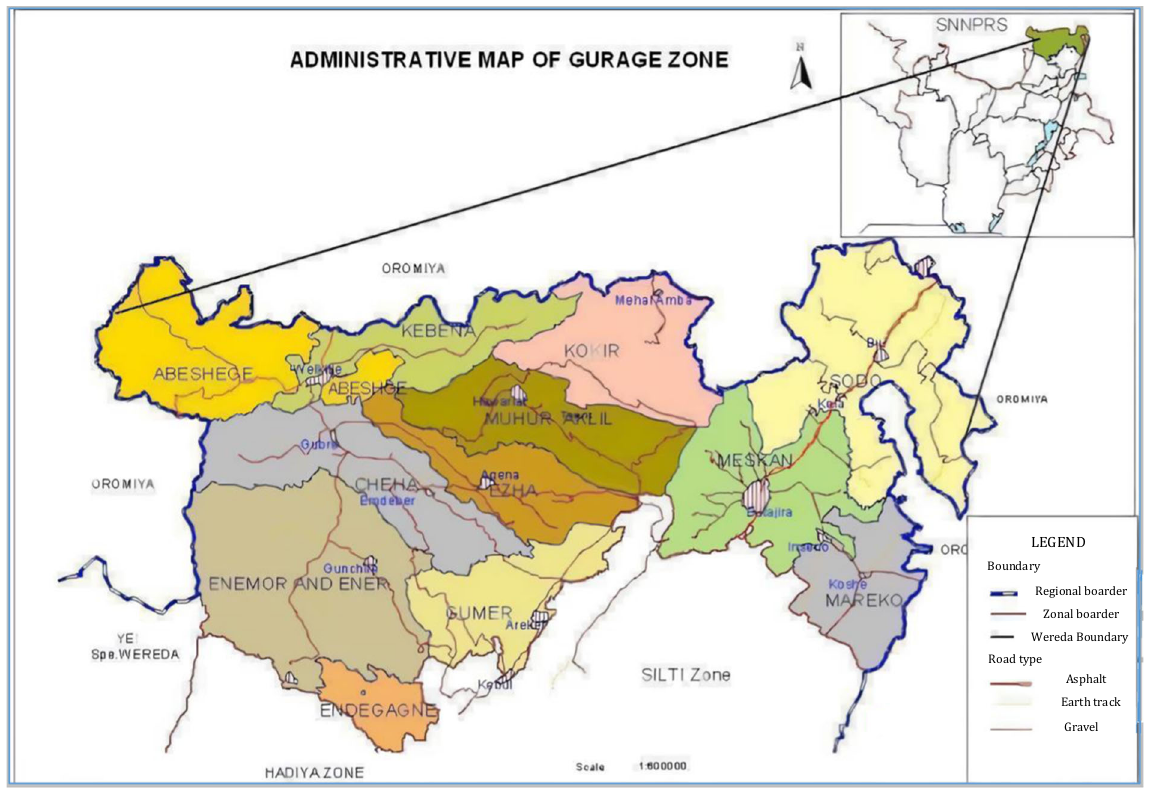
Fig. 1 An image that shows the thirteen Woredas and two reform administrations of the Gurage